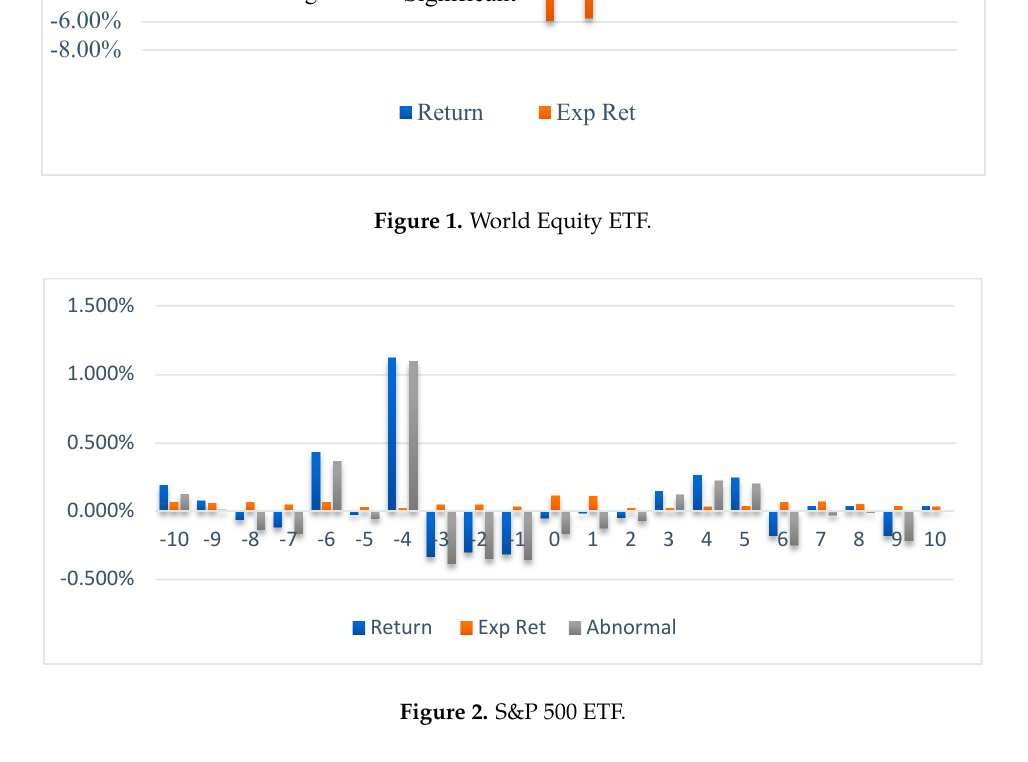
Figure 2. S&P 500 ETF.